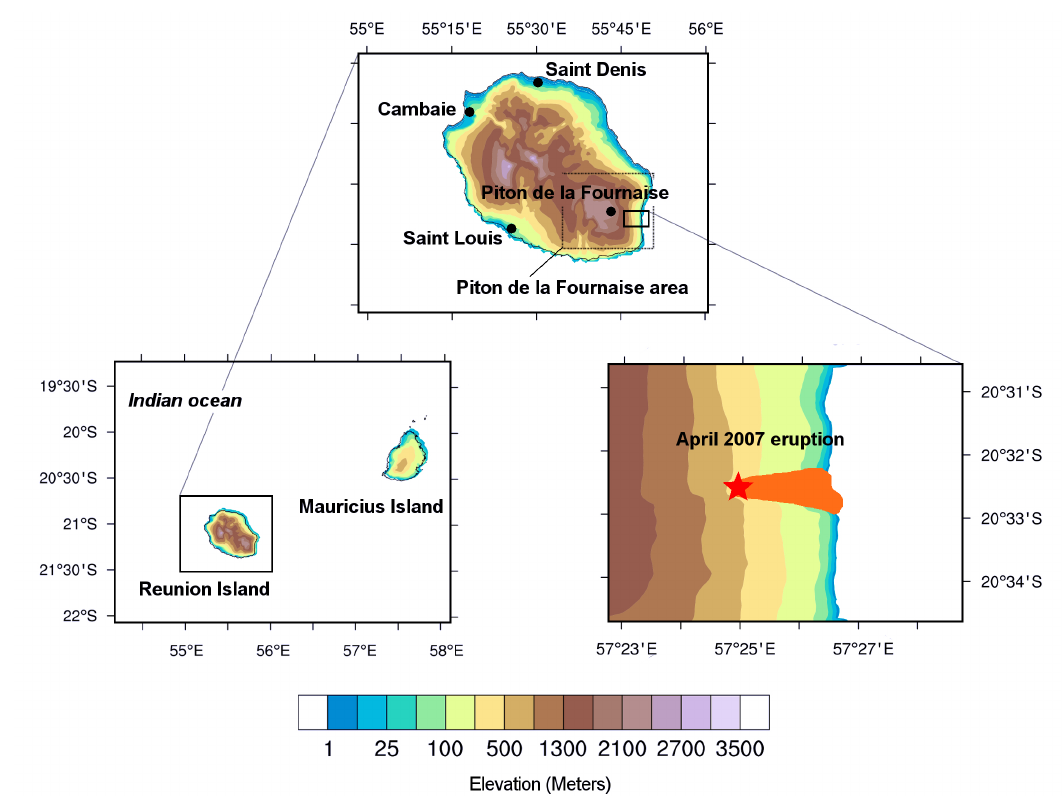
Figure 1. Different embedded domains at 2 km, 500 m, and 100 m used for the simulation of the eruption of the Piton de la Fournaise, April